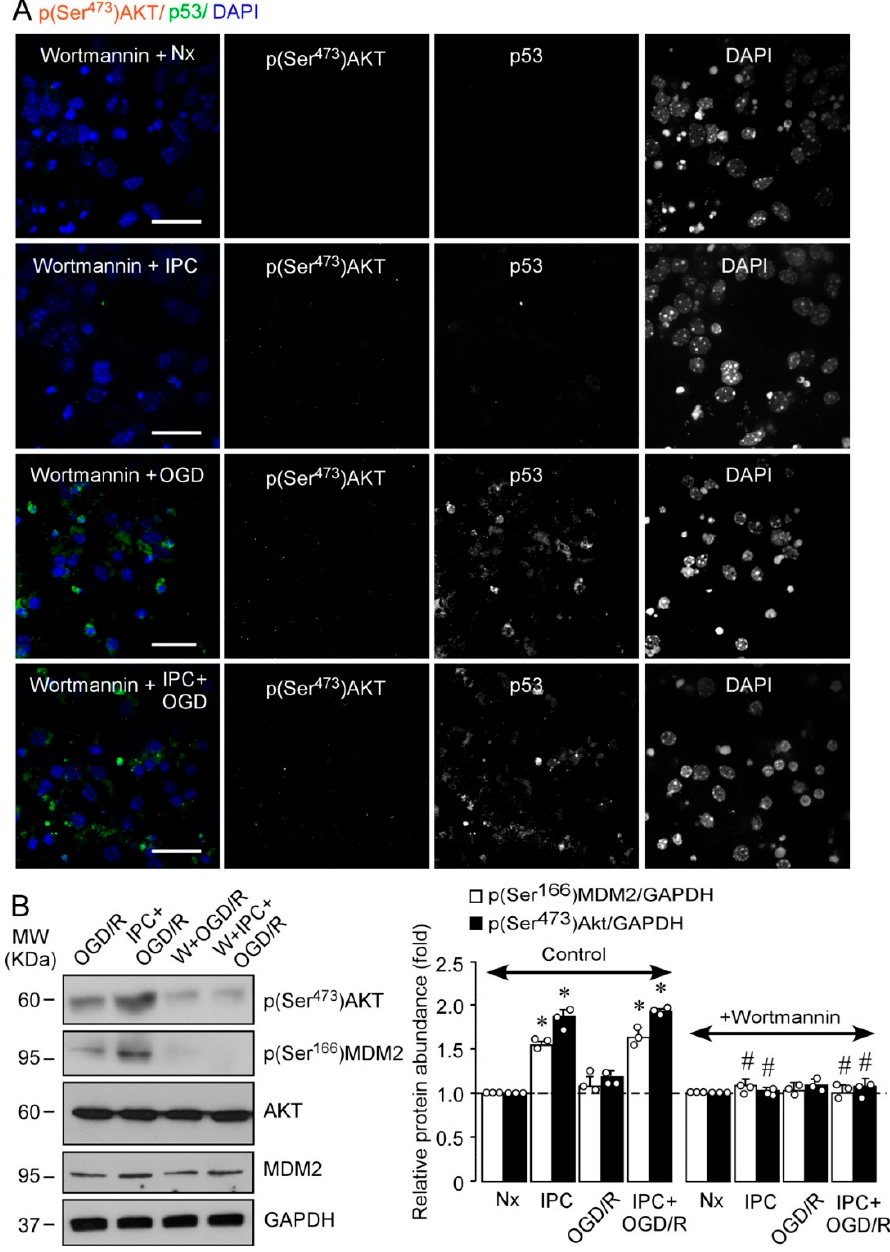
Figure 2. Inhibition of PI3K activity abrogates IPC-induced phosphorylation of AKT at Ser 473 and MDM2 at Ser 166 , leading to p53 stabilization after OGD/R. Mouse cortical neurons (9–10 DIV) were treated with wortmannin for 30 min before IPC + OGD/R, Nx, IPC, and OGD/R. ( A ) Representative images of cortical neurons stained with p(Ser 473 )AKT (red), p53 (green), and DAPI (blue, nuclear marker). Scale bar, 50 μ m. ( B ) p(Ser 473 )AKT and p(Ser 166 )MDM2 protein levels were analyzed by Western blot. GADPH was used as loading control. Representative blots and relative protein abundance quantification from three different neuronal cultures are shown. MW, molecular weight. Data are means ± SEM. Statistical analysis of the results was evaluated by one-way ANOVA followed by Bonferroni post hoc test. * p < 0.05 versus Nx and OGD/R; # p < 0.05 versus control.